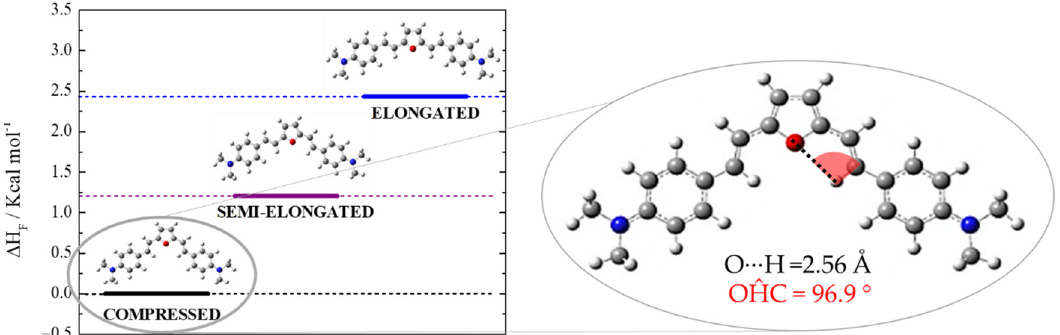
Figure 3. Relative energy of the ground-state conformers of DMA-QF in Tol (CPCM) calculated by the B3LYP/6 − 31 + G(d) model.